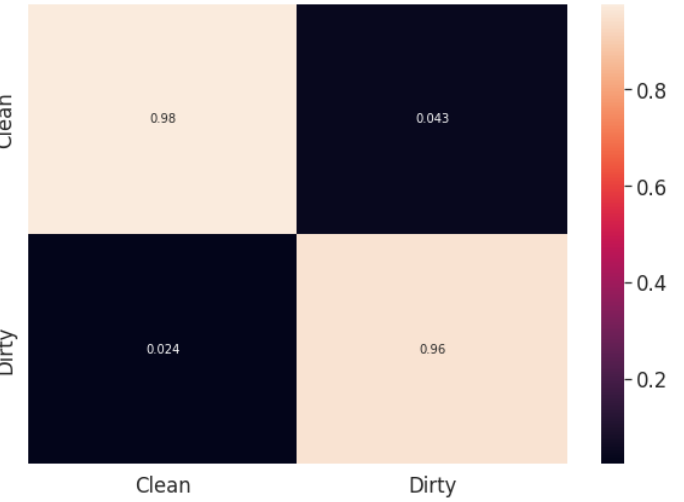
Figure 11. Confusion metrics in percentage where columns represents ground truth and rows represents predicted class.